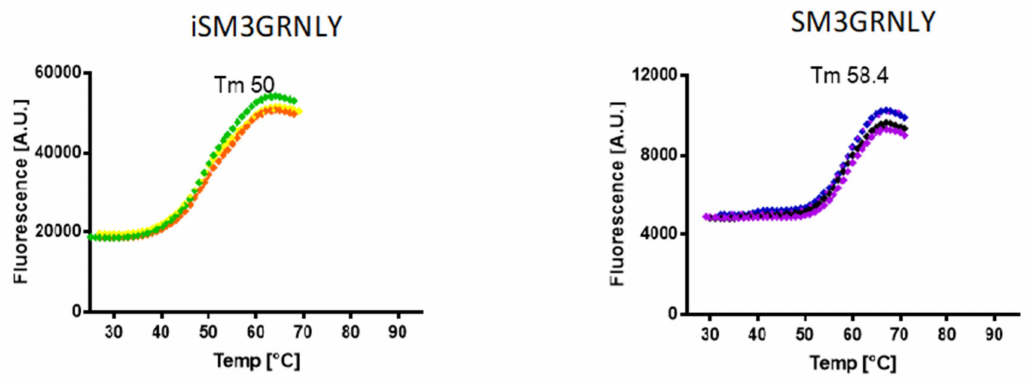
Figure 4. Thermal stability of immunotoxins. SM3GRNLY and iSM3GRNLY stability was tested by di ff erential scanning fluorimetry using Sypro orange dye in the indicated temperature range at pH 7. Triplicate curves are shown and the calculated average temperature (Tm) indicated in each